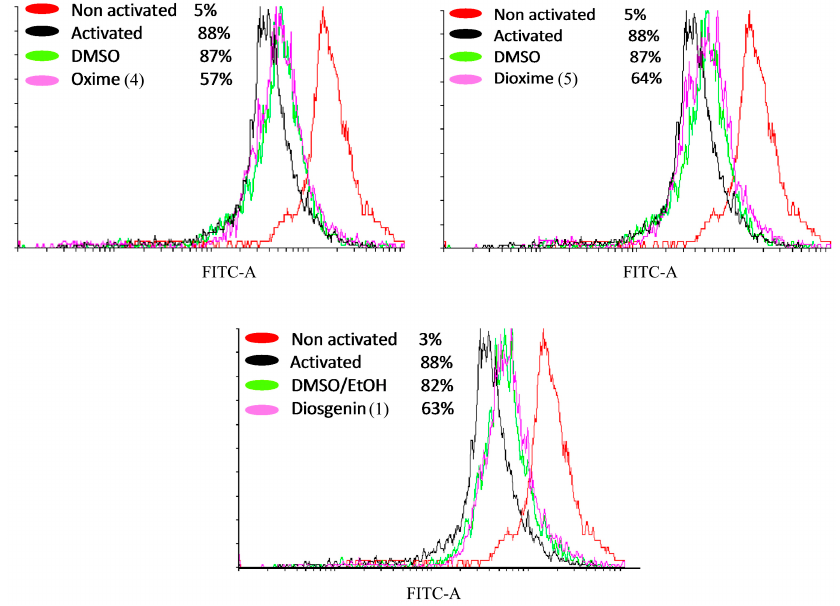
Figure 7. Antiproliferative activity of 1 , 4 , and 5 compounds on human lymphocyte cell cultures at the respective concentrations ( 1 (15 g/mL), 4 (5.6 g/mL), and 5 (22 g/mL)).